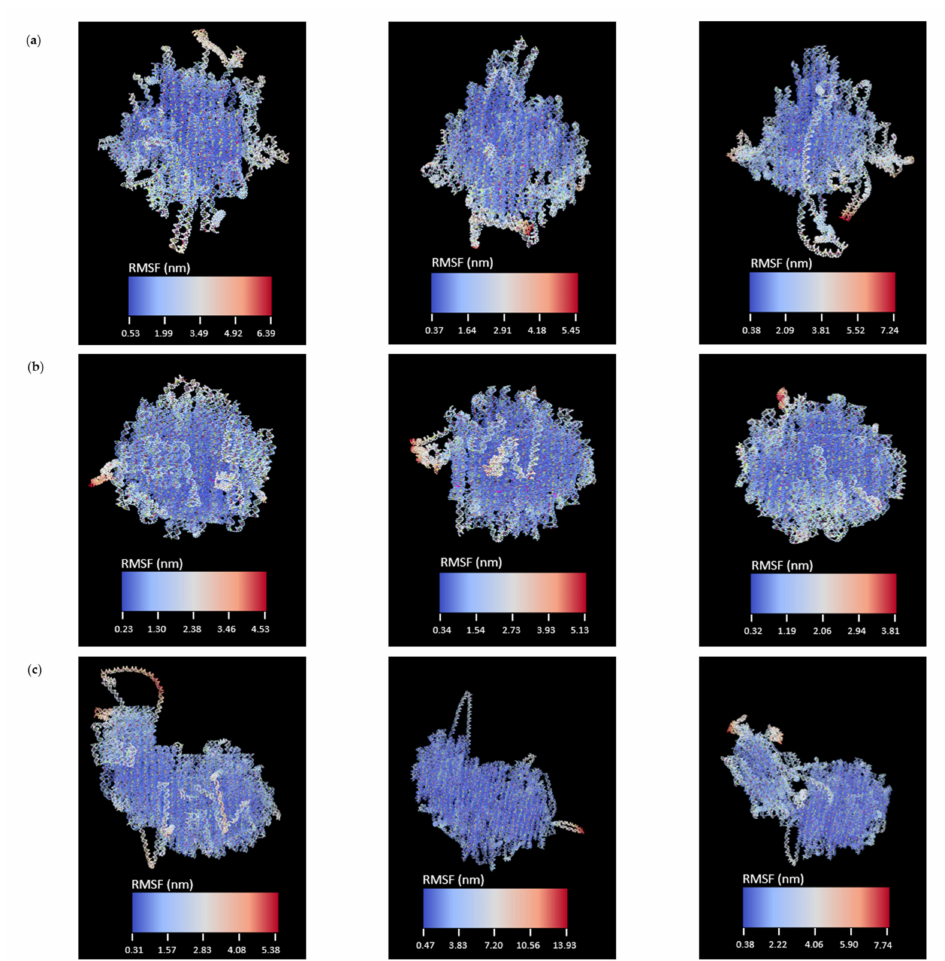
Figure 8. RMSF of structures generated with filling application from Figure 6. The RMSFs are calculated relative to the average configurations generated over the entire trajectory. The images illustrate the patterns appearing in the RMSF calculations using a colormap with a smooth transition from a cool to warm color: ( a ) RMSF pattern for tetrahedron as the outer bounds of the design space. Each configuration, from left to right, has a total length of 7595 bp, 7784 bp, and 7728 bp; ( b ) RMSF pattern for snub cube mesh as the outer bounds of the design space. Each structure, from left to right, has a total length of 9275 bp, 8484 bp, and 8582 bp; ( c ) RMSF pattern for Stanford bunny mesh as the outer bounds of the design space. Each configuration, from left to right, has a total length of 14,595 bp, 13,531 bp, and 14,105